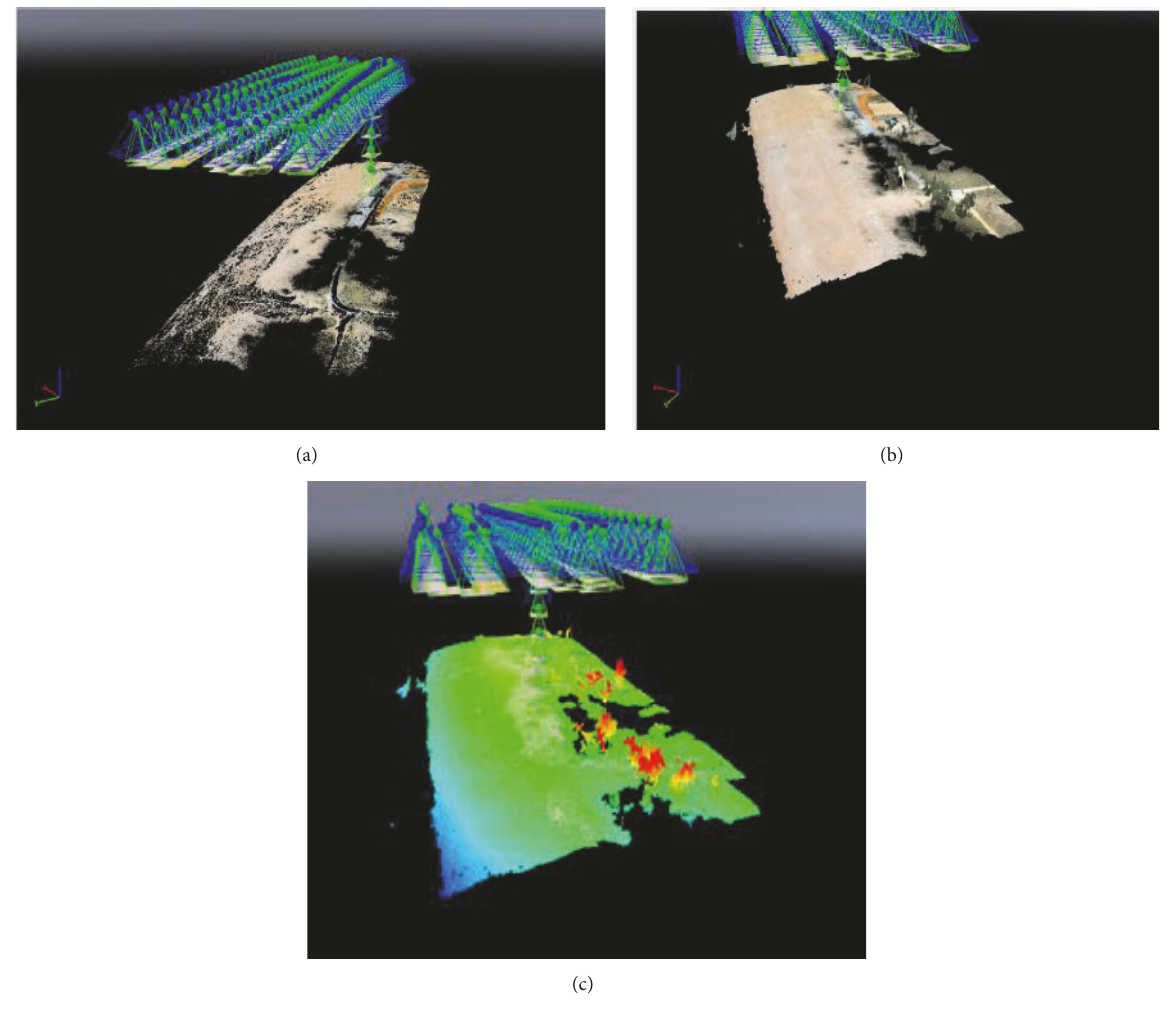
Figure 8: Point cloud: (a) sparse point cloud, (b) true color, and (c) false color.